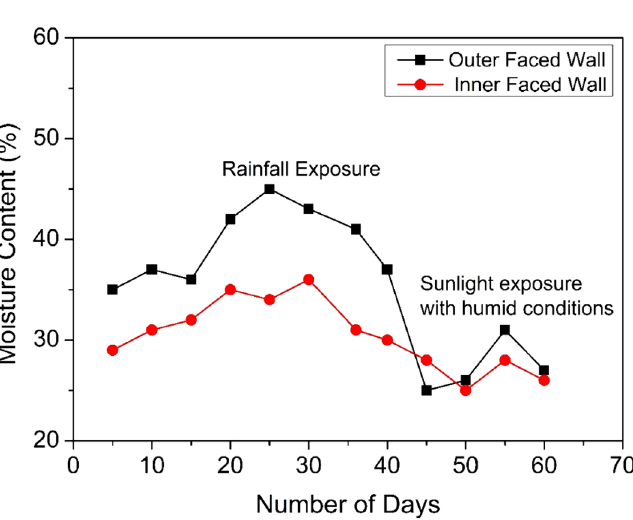
Figure 14. Moisture content variation of agro-waste gypsum wall in rainfall and sunlight conditions with humidity levels of 70–90% in July to August